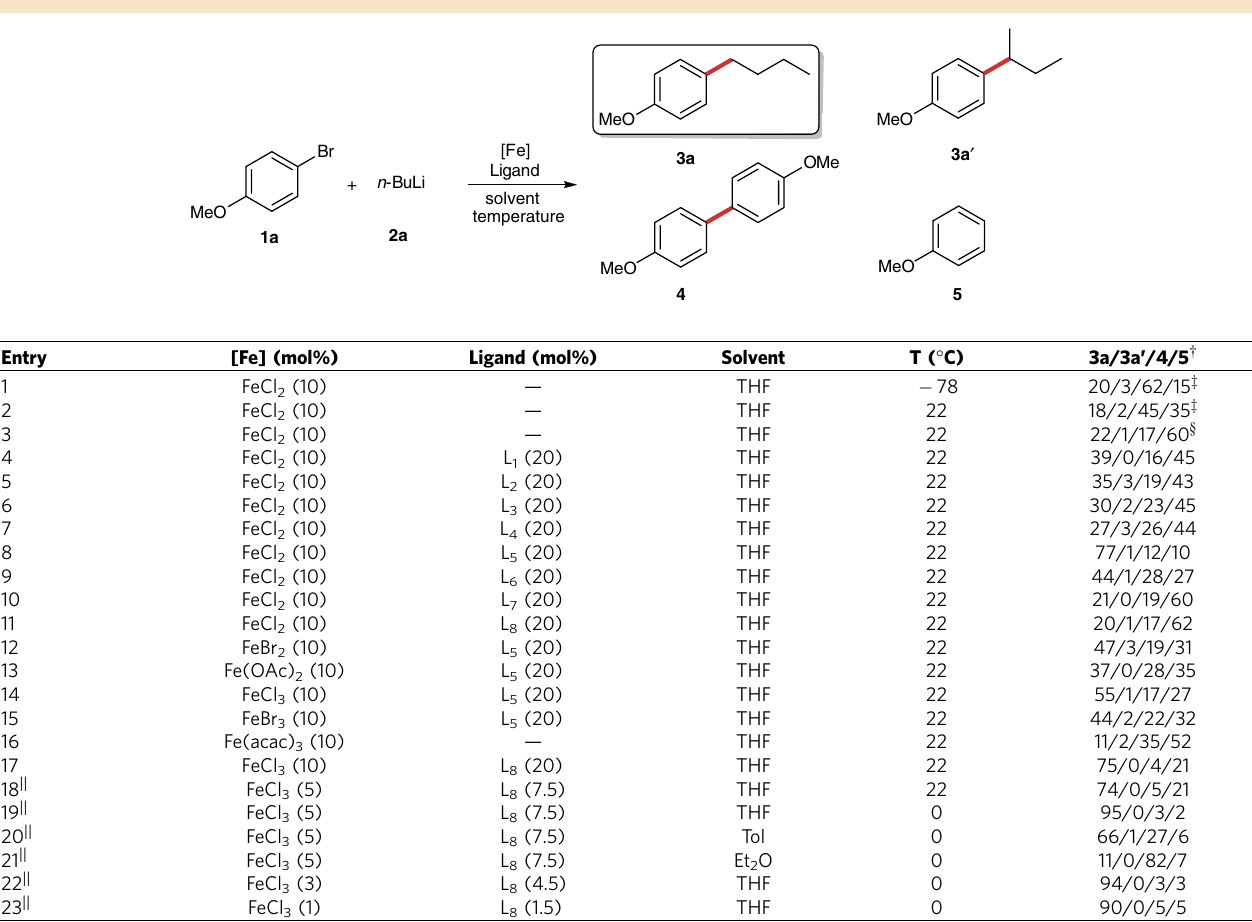
Table 1 | Selected optimization results for C( sp 2 )-C( sp 3 ) cross-coupling of 4-methoxybromobenzene (1a) and n -BuLi (2a)*.